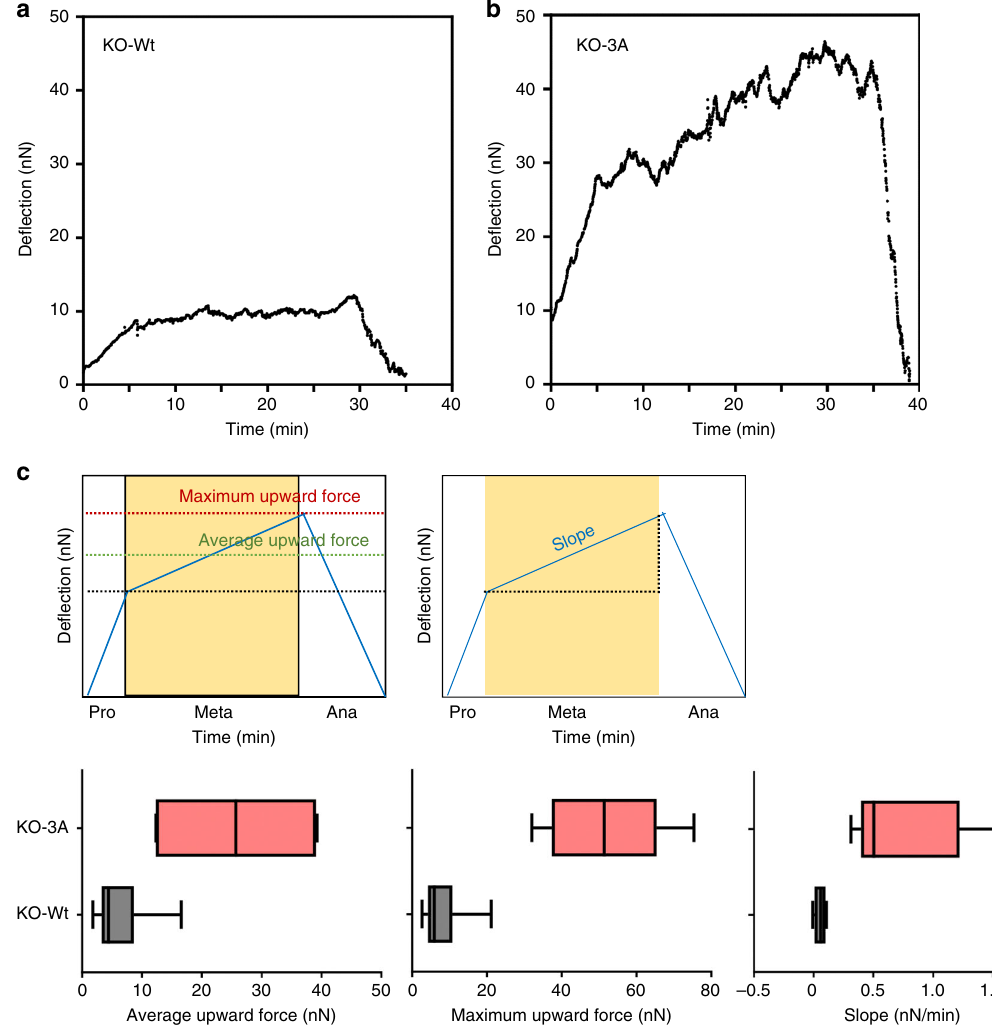
Fig. 4 Expression of DIAPH1 – 3A increases cortical tension. Constant-height assay using AFM. Graphs show the upward de fl ection of the cantilever in the mitotic progression of KO-Wt ( a ) or − 3A ( b ) cells. See Methods for the details. Representative results of six independent experiments are shown. c (Left) Average upward force during metaphase. (Middle) Maximum upward force during metaphase. (Right) Slope during metaphase. Box plots indicate median, interquartile values, and range. Cartoons (upper panels) illustrate the average upward force, maximum upward force, and